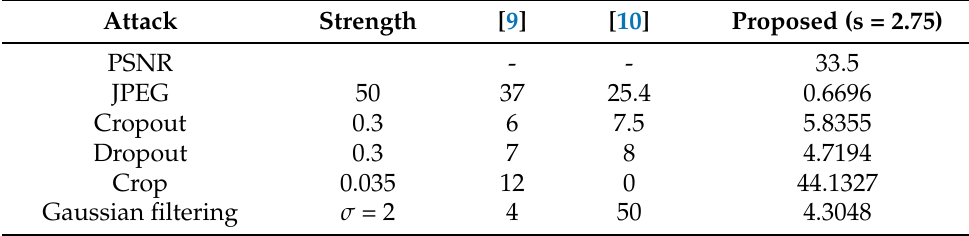
Table 6. Comparison with the recent researches for 2D